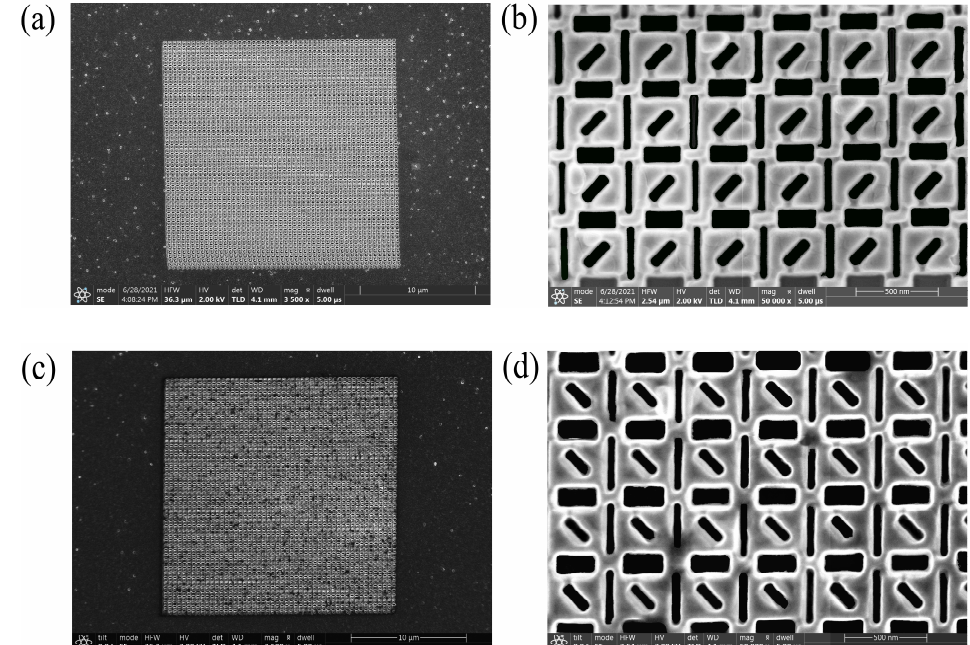
Figure 8. The SEM images of the fabricated samples. ( a ) The SEM images of the left ‐ handed structure. ( b ) The SEM partial images of the left ‐ handed structure. ( c ) The SEM images of the right ‐ handed structure. ( d ) The SEM partial images of the right ‐ handed structure.